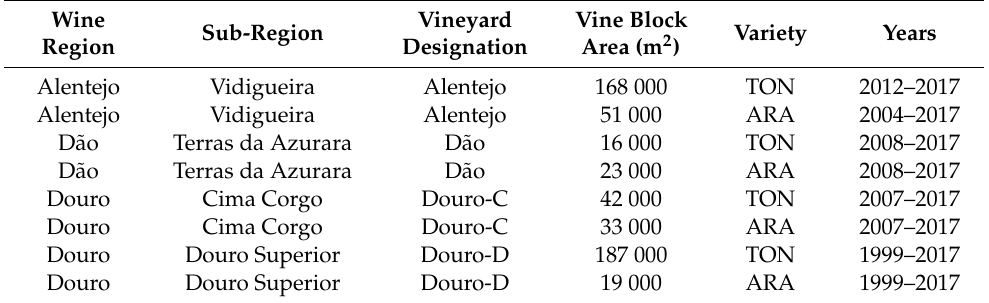
Table 1. Selected maturation data. Wine region, sub-region, vineyard designation, vine block area, variety (Touriga Nacional, TON, and Aragonez, ARA) and the period of the records are listed. Vineyard Vine Block Wine Variety Sub-Region Designation Area (m 2 ) Region